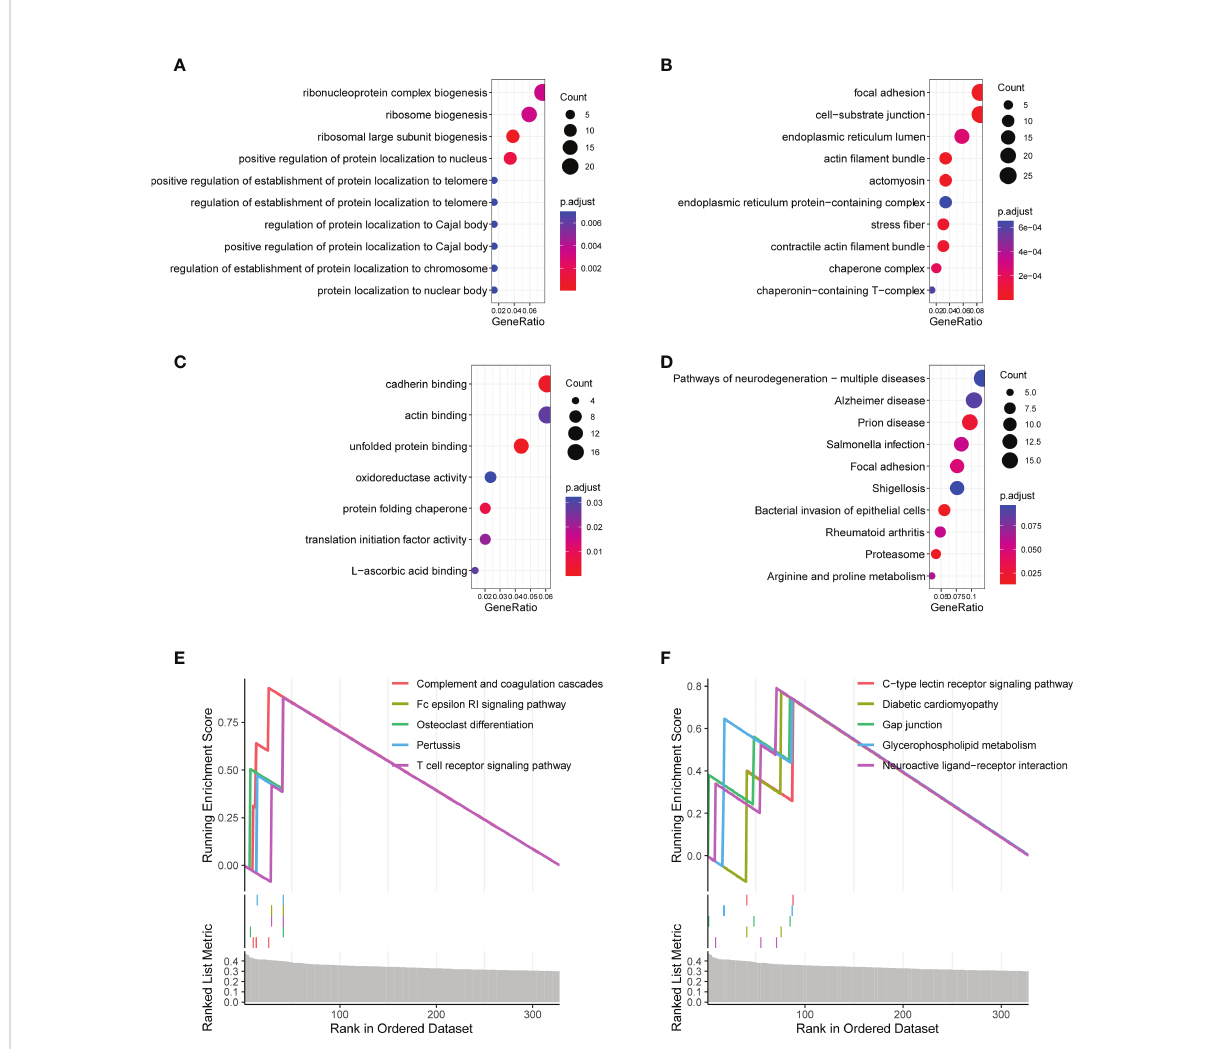
FIGURE 5 Functional enrichment analysis of the circadian rhythm-related gene signature. (A) Enriched biological processes included ribonucleoprotein complex biogenesis, ribosome biogenesis, and ribosomal large subunit biogenesis. (B) Enriched cell components included focal adhesion, cell – substrate junction, endoplasmic reticulum lumen, and actin fi lament bundle. (C) Enriched molecular functions included cadherin binding, actin binding, and unfolded protein binding. (D) Enriched Kyoto Encyclopedia of Genes and Genomes (KEGG) pathways included focal adhesion, proteasome, arginine, and proline metabolism. (E, F) The gene set enrichment analysis showed the top 10 KEGG signaling pathways, including complement and coagulation cascades as well as the Fc epsilon RI signaling pathway and T cell receptor signaling